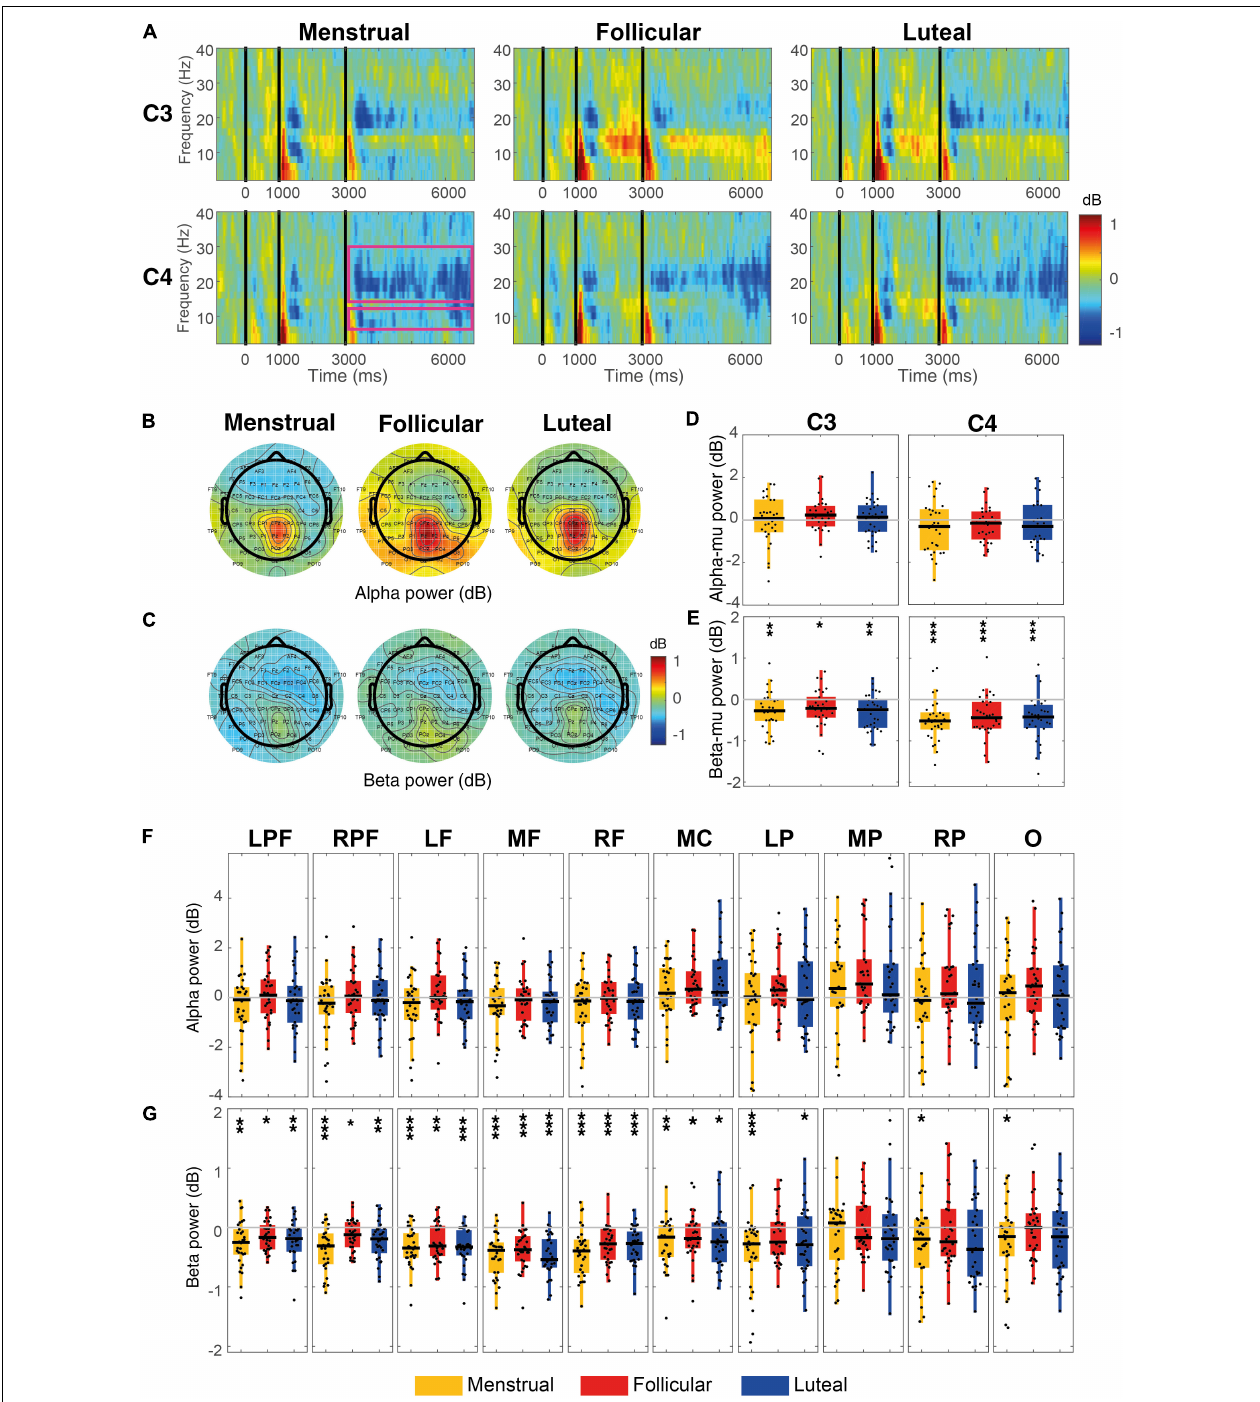
FIGURE 5 | Event-related power for each menstrual cycle phase during the AO condition. (A) Displays time-frequency plots of C3 and C4 by menstrual cycle phase. The pink rectangles in the first column of the C4 row indicate the time-frequency interest limits: Event B time (3.15–7 s), alpha-band (8–13 Hz), and beta-band (15–30 Hz). (B) Shows topographies of the mean alpha power for each menstrual cycle phase. (C) Shows topographies of the mean beta power for each menstrual cycle phase. Boxplots and scatter plots are presented in (D) with alpha-mu power, in (E) with beta-mu power per phase of the menstrual cycle and per cortical region, in (F) with alpha power for various cortex regions, and in (G) with beta power for various cortex regions. Asterisks located above boxplots indicate that the power was significantly different from zero in the menstrual cycle phase below. Asterisks located below boxplots indicate that the power was significantly different between the two menstrual cycle phases indicated by the horizontal line. * p < 0.05, ** p < 0.01, *** p < 0.001; C3, left central, C4, right central, LPF, left prefrontal, RPF, right prefrontal, RF, right frontal, MF, medial frontal, LF, left frontal, MC, medial central, LP, parietal, MP, medial parietal, RP, right parietal and O,